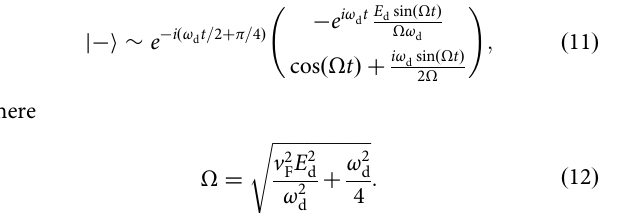
≈ 28 MV m − 1 . We also see the d